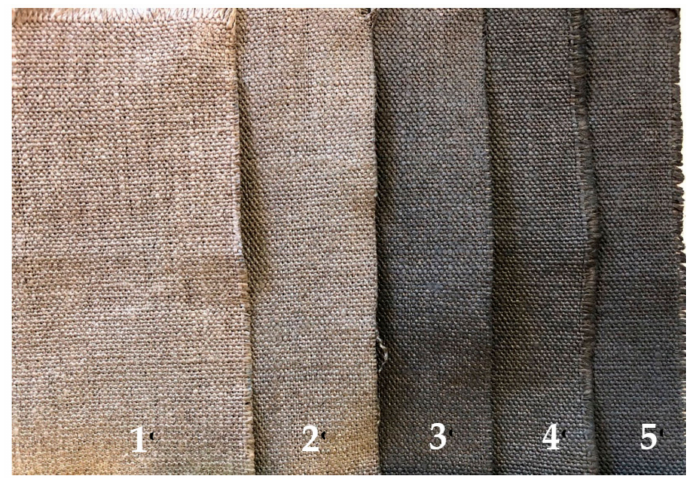
Figure 3. Images of the developed samples: (1) FlaxCPG, (2) FlaxCPG + 0.1%, (3) FlaxCPG + 0.5%, (4) FlaxCPG + 1% and (5) FlaxCPG + 2%